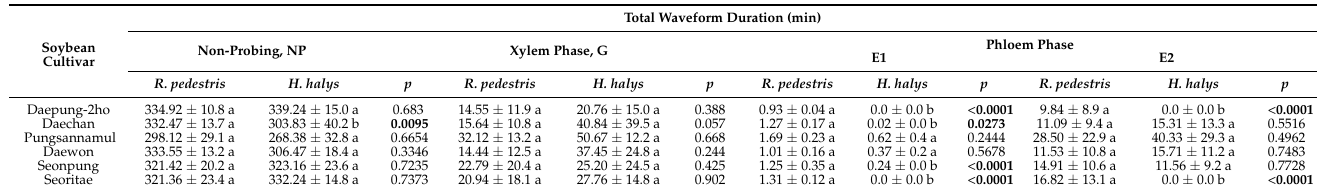
Means followed by the same letter (lowercase), in the same row, do not differ significantly ( p > 0.05) using Student’s t -test. Highlighted in bold are those variables that showed striking significant differences between insect